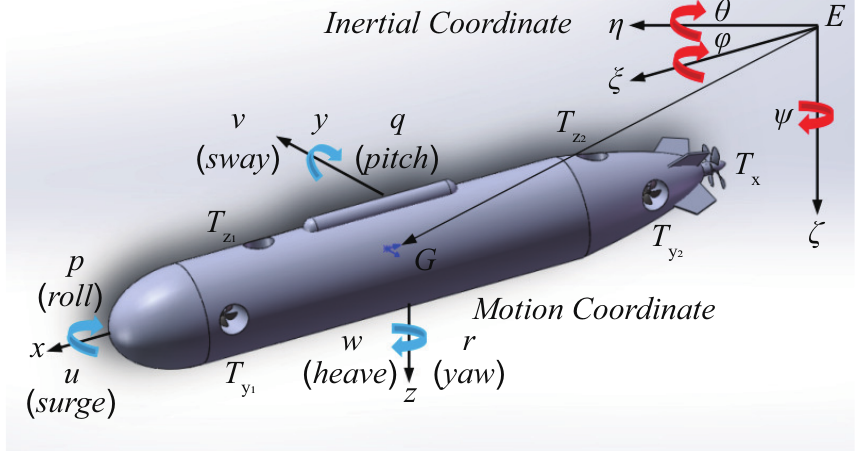
Figure 1. Reference